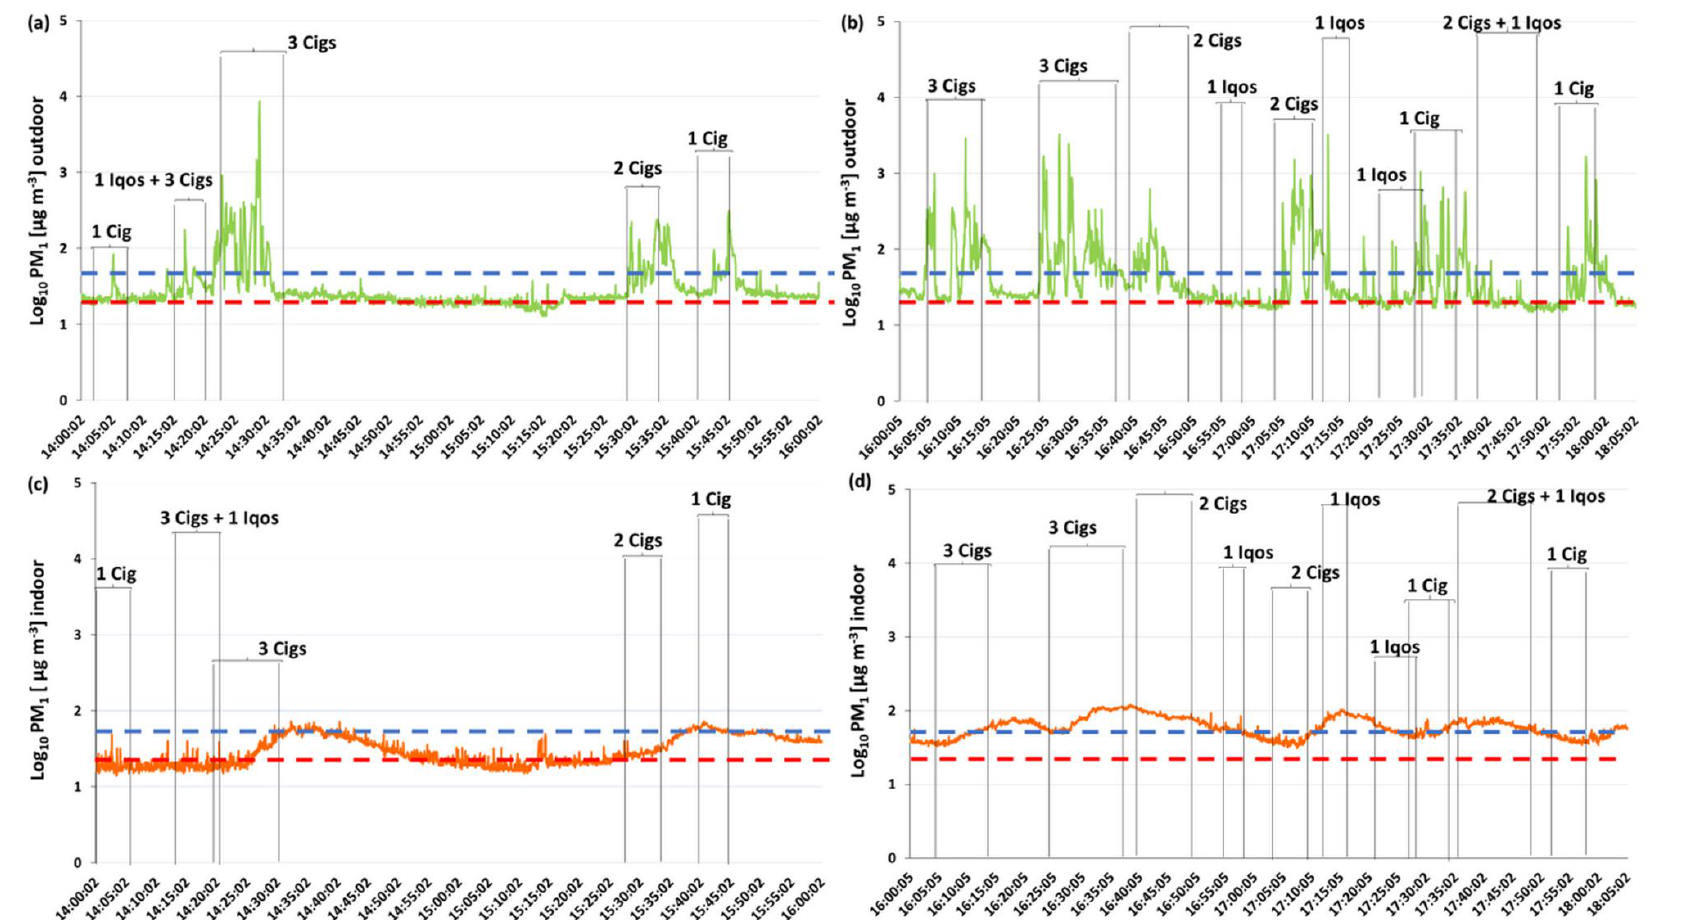
Figure 2. Levels of PM 1 ( µ g m − 3 ), expressed in Log(10)PM 1 , measured, respectively, outdoors ( a, b ) and indoors ( c, d ) during the afternoon measuring session. 1. cig = one conventional cigarette; RYO = “Rolled your own” hand-rolled cigarette; e-cig = electronic cigarette. Red dropped line: WHO guideline value for PM 2.5 (24-h mean). Blue dropped line: WHO guideline value for PM 10 (24-h mean).